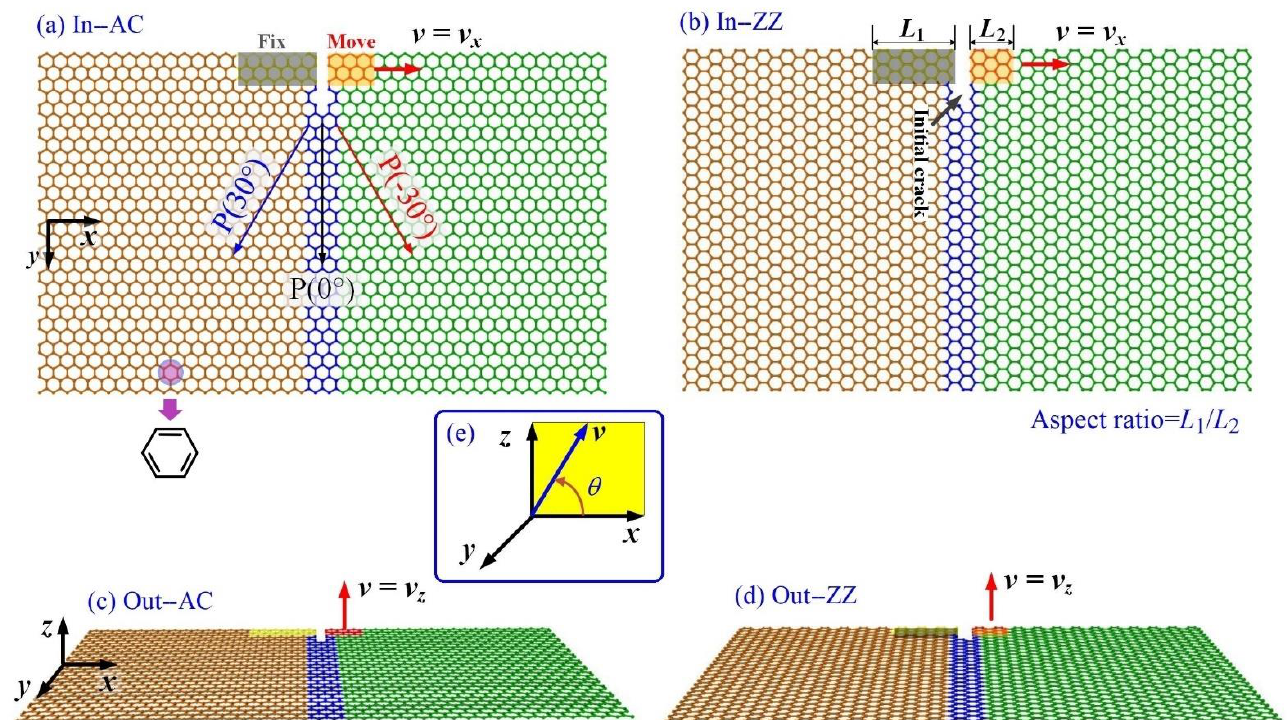
Figure 1. Geometry of monolayer graphene sheets with armchair (AC) crack or zigzag (ZZ) crack. The atoms in the fixed area with a length of L 1 are fixed in tearing. Meanwhile, the atoms in the moving area with a length of L 2 move synchronously along a direction with the speed of v . The ribbons have similar sizes of ~100.8 Å × ~60.3 Å. The depth of the initial crack is ~5 Å. ( a ) In-plane tearing along the armchair crack (In-AC), and ( b ) along the zigzag crack (In-ZZ); ( c ) out-of-plane tearing along the armchair crack (Out-AC), and ( d ) along the zigzag crack (Out-ZZ). ( e ) Oblique tearing. The vector v is in the xz-plane. “ θ = 0 ◦ ” means an in-plane tearing, while “ θ = 90 ◦ ” means an out-of-plane tearing. “0 ◦ < θ < 90 ◦ ” illustrates an oblique tearing. Table 1. Initial parameters of graphene ribbons with different aspect ratios